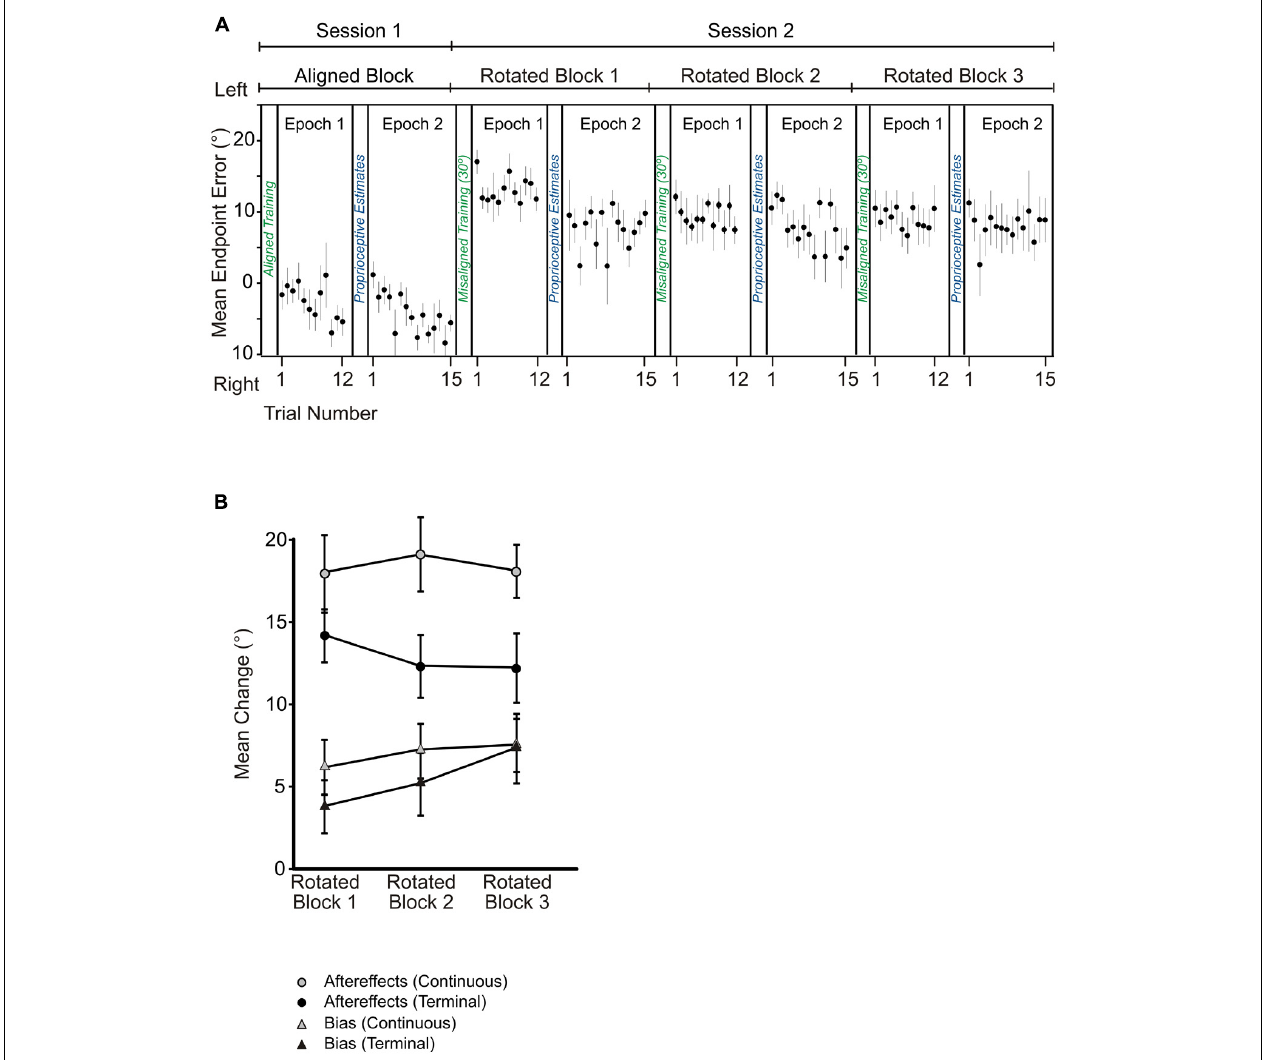
performance in the first testing session with the aligned hand-cursor. Dark symbols indicate mean performance from the terminal feedback experiment while gray symbols represent those from the continuous feedback experiment (Salomonczyk etal., 2011). Mean changes in degrees were averaged across subjects and across target/reference marker locations. Error bars represent standard error of the